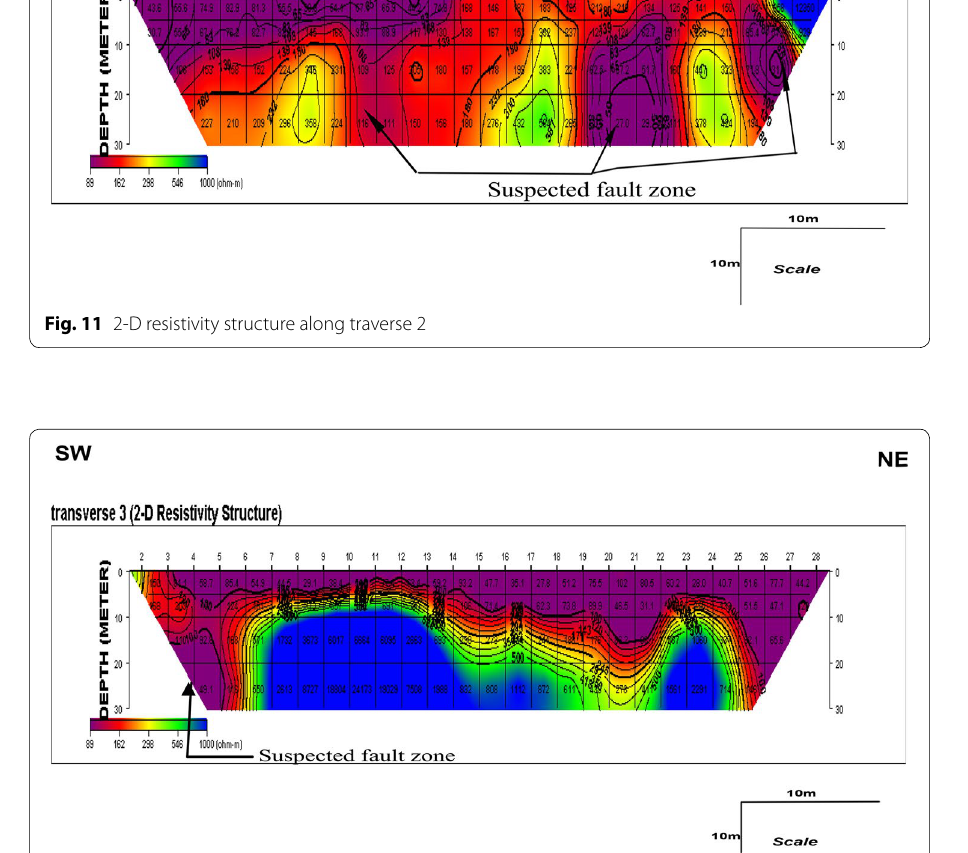
Fig. 12 2-D resistivity structure along traverse